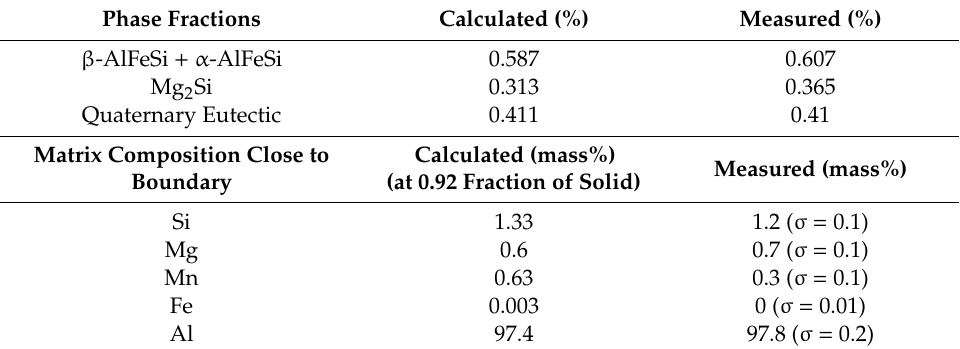
Figure 3. As-cast microstructure of alloy 6082. Reprinted with permission from International Journal of Materials Research, Vol. 105 (2014) pp. 1202–1209 by P.I. Sarafoglou and G.N. Haidemenopoulos, (c) Carl Hanser Verlag GmbH and Co.KG, Muenchen.